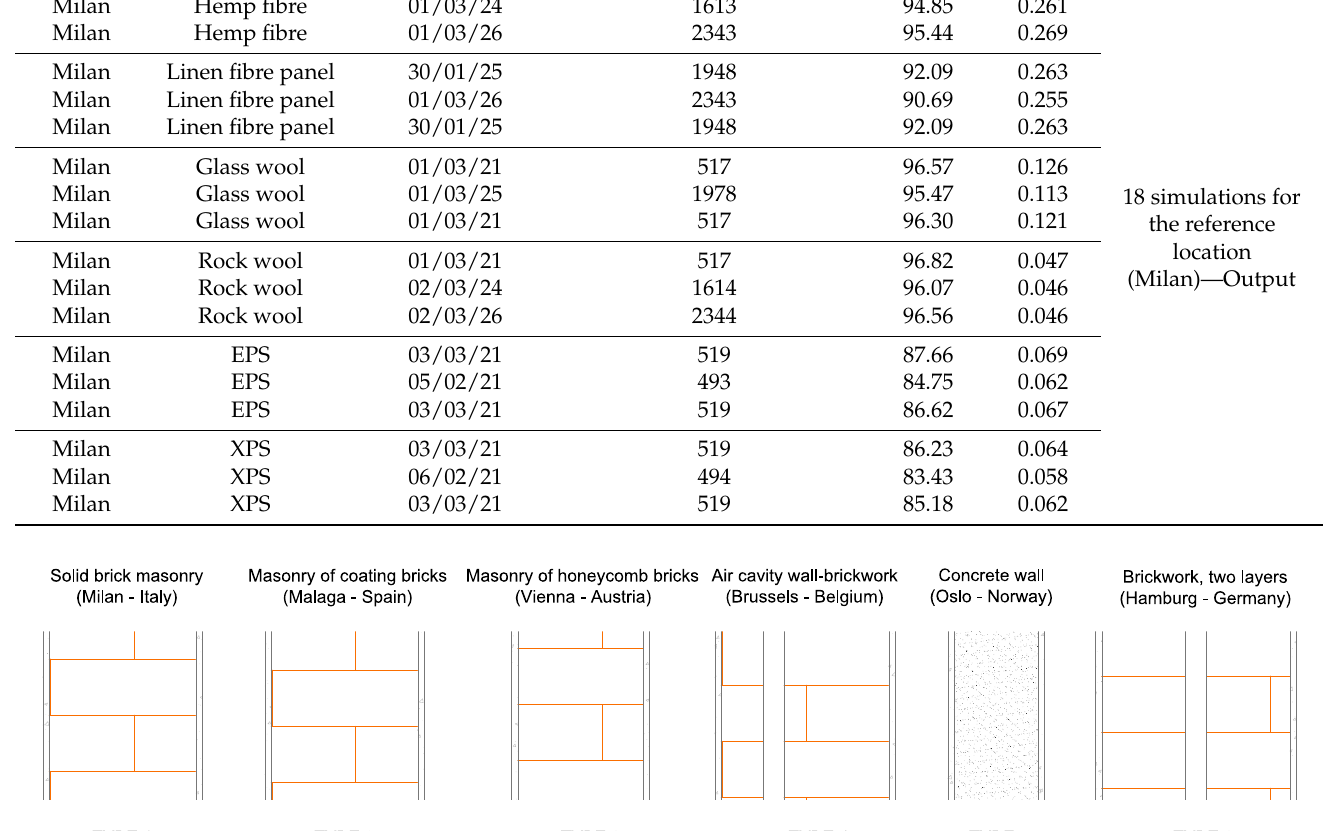
Figure 2. Introduction of the insulating panel in the various types of wall stratigraphy determined by TABULA by reference location.